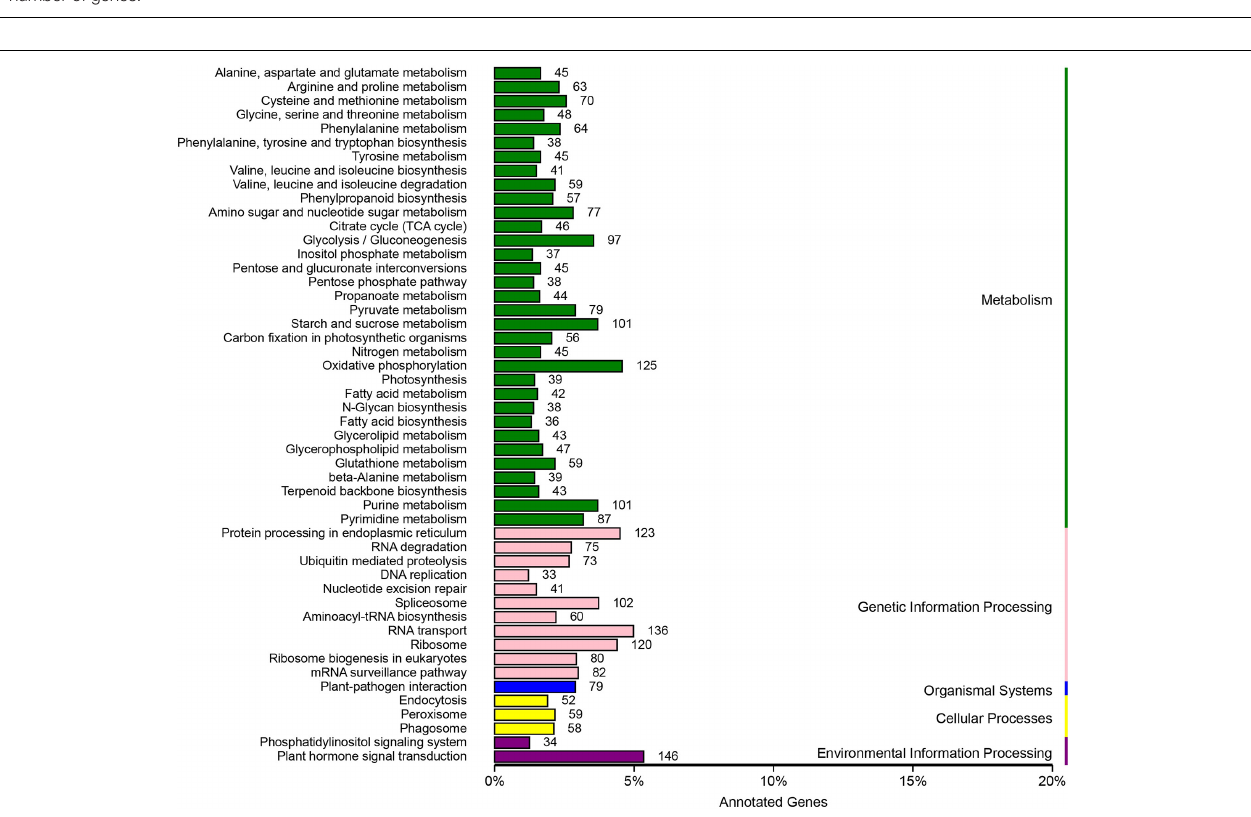
FIGURE 6 | The SNPs of Munake grape annotated according to the KEGG database, the x-axis shows the taxonomical content of KEGG data. The y-axis shows the number of genes.